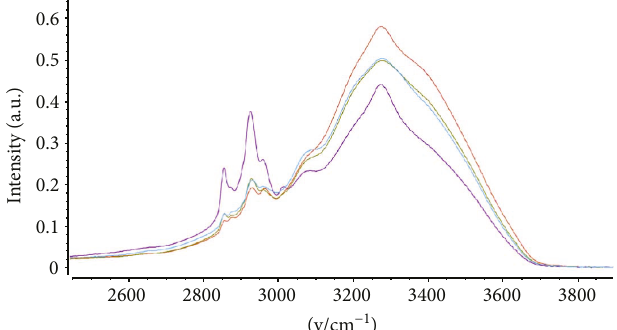
Figure 7: Comparison of high-frequency FT-IR spectra of di ff erent fresh salmon components.